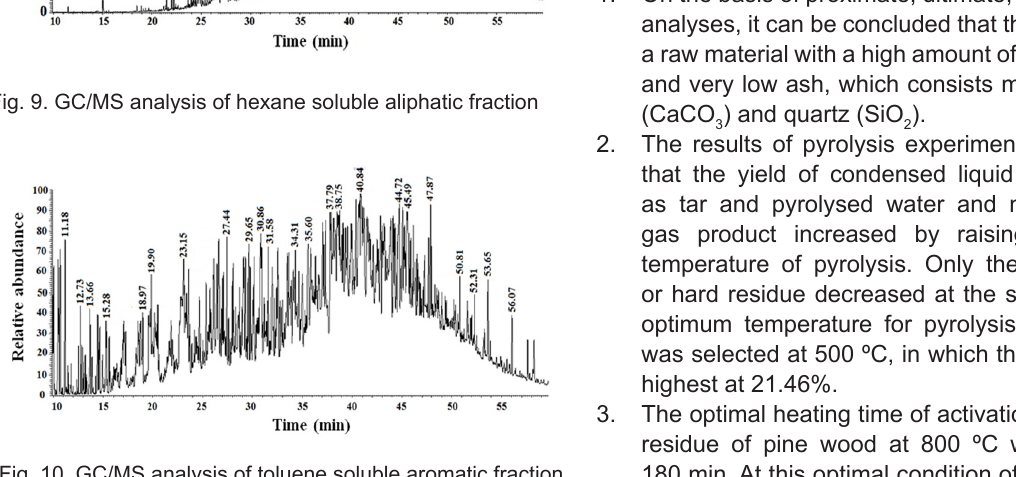
Fig. 10. GC/MS analysis of toluene soluble aromatic fraction